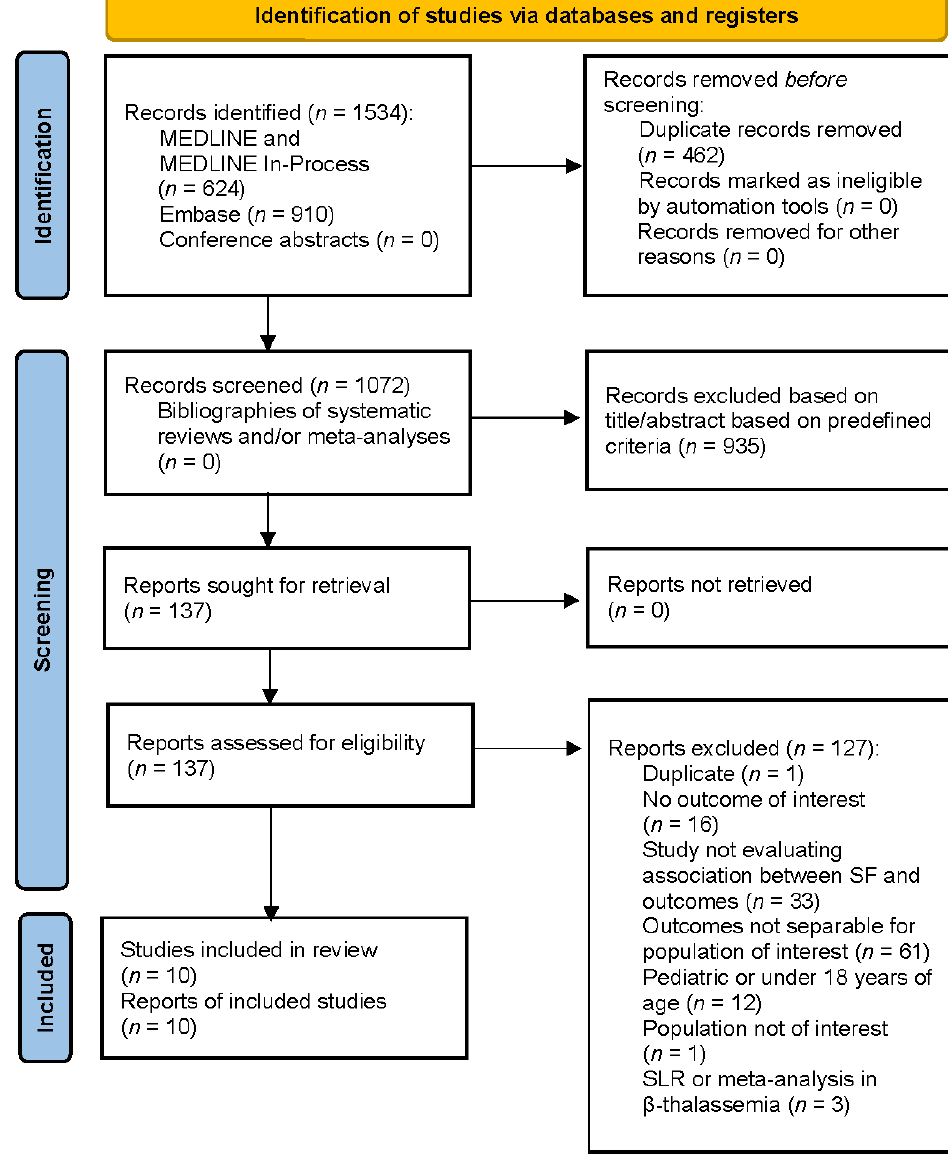
Figure 1. PRISMA diagram of attrition for β -thalassemia studies. SF, serum ferritin; SLR, systematic literature review.